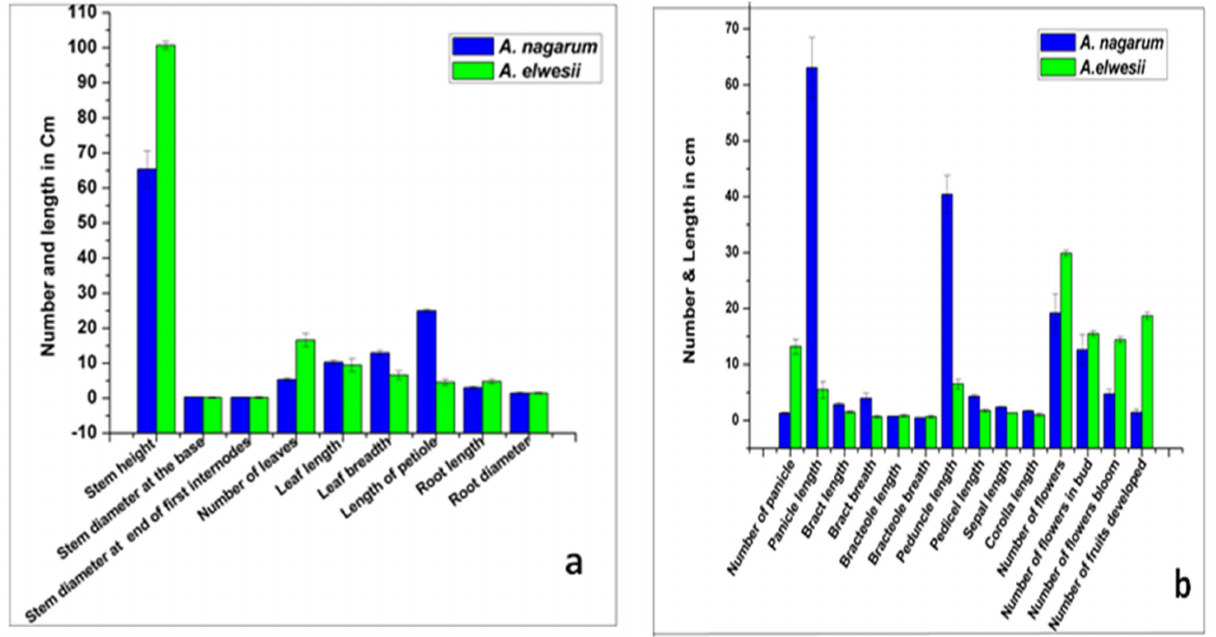
Fig. 2 a. Morphological characteristics of A. nagarum and A. elwesii ; b. Characteristics of A. nagarum and A. elwesii